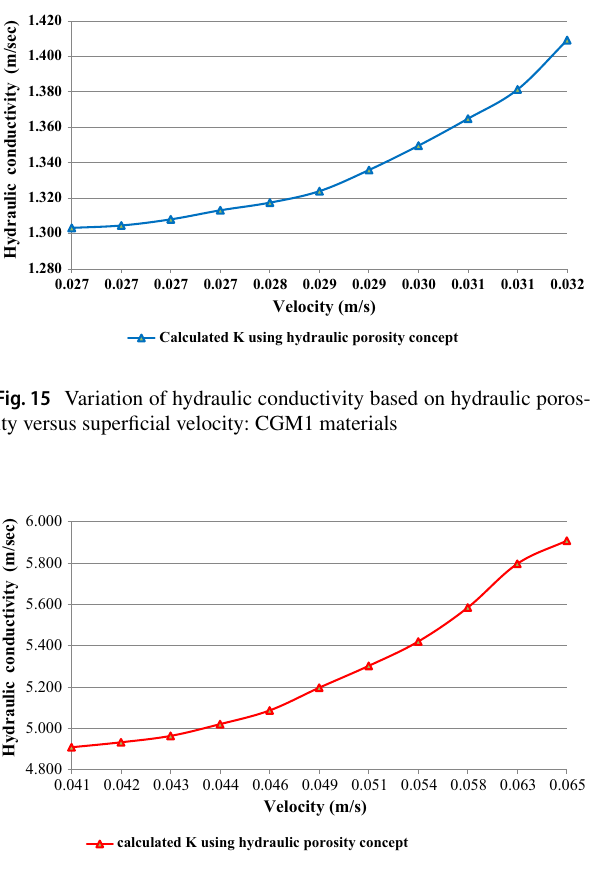
Fig. 16 Variation of hydraulic conductivity based on hydraulic poros- ity versus superficial velocity: CGM2